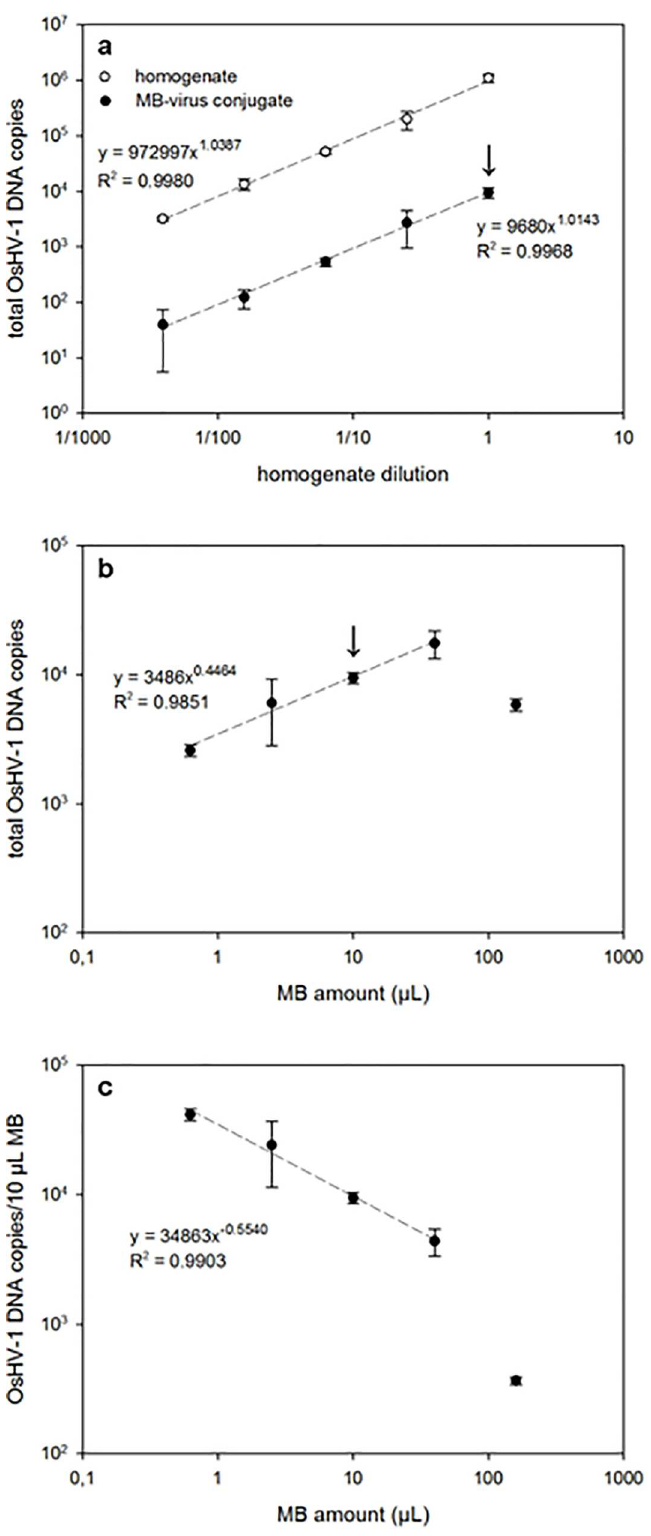
Fig 3. Calibration curves using 4-fold serial dilutions of homogenate (a) and MBs (b, c) while maintaining MB amount (10 μL) and using non-diluted homogenate, respectively. Arrows indicate the same MB/homogenate ratio in (a) and (b). Panel (c) is normalised to 10 μL of MBs. https://doi.org/10.1371/journal.pone.0205207.g003 PLOS ONE | https://doi.org/10.1371/journal.pone.0205207 October 3,